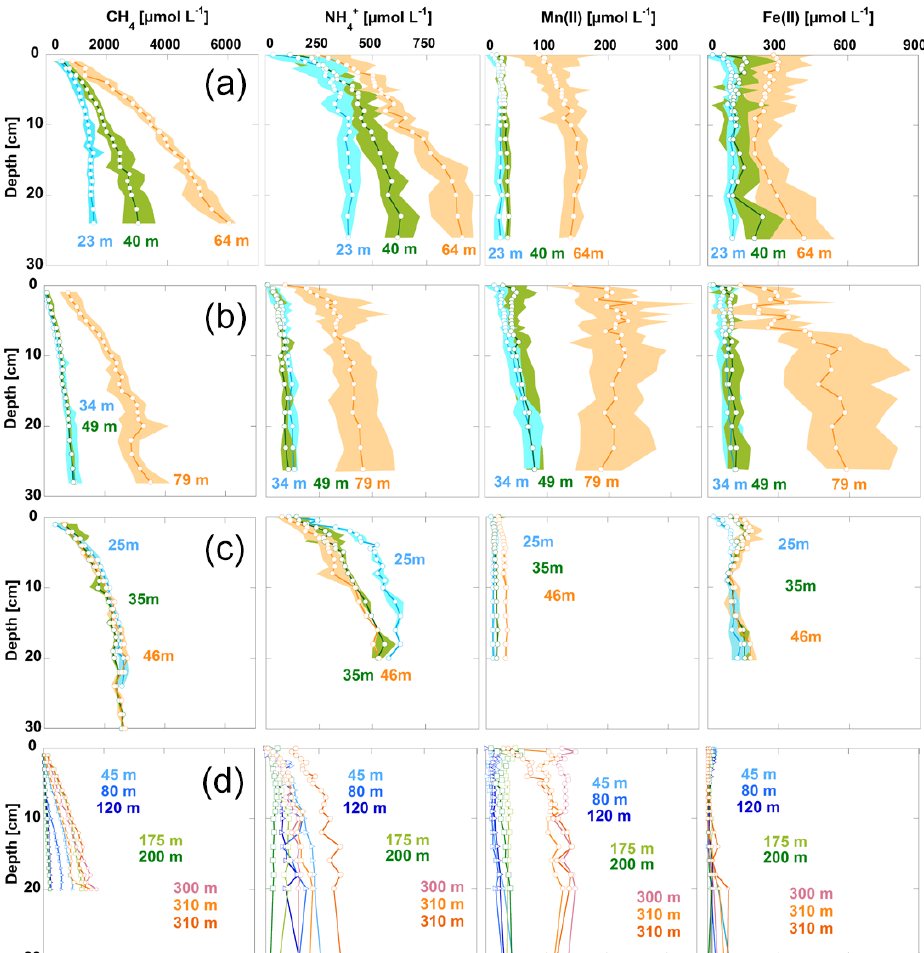
Figure 1. Porewater concentration profiles of NH + , CH 4 , Mn(II), and Fe(II) from (a) Lake Baldegg, (b) Lake Aegeri, (c) Lake Hallwil, 4 and (d) Lake Geneva. Bold lines are averaged values of up to five measurements, while the areas of corresponding colors show the range of minimal and maximal values. Coring sites of Lake Geneva (d) were sampled only